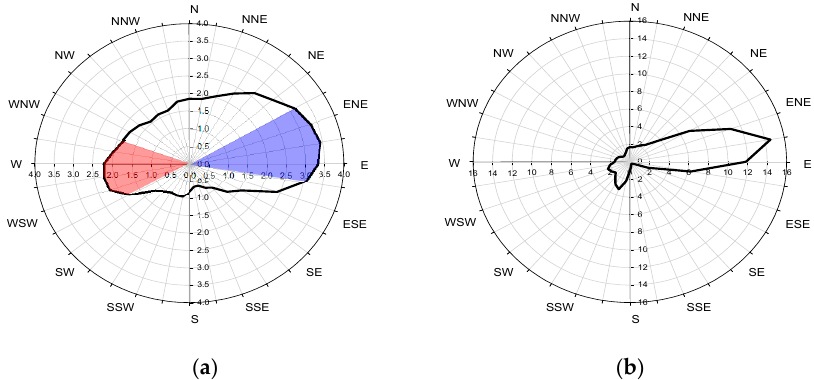
Figure 3. Wind speed and wind direction data acquired at meteorological stations near the urban renewal site for 2003–2013. ( a ) Mean wind speed for various wind directions; ( b ) after urban renewal probability of each wind direction.